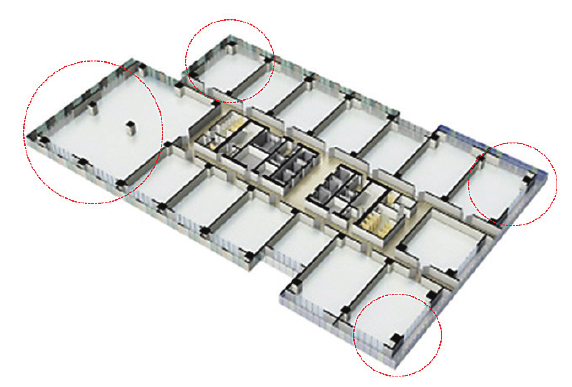
Figure 4. Example of a two way balconies unit (source: Lotte Higgs U Tower, available from